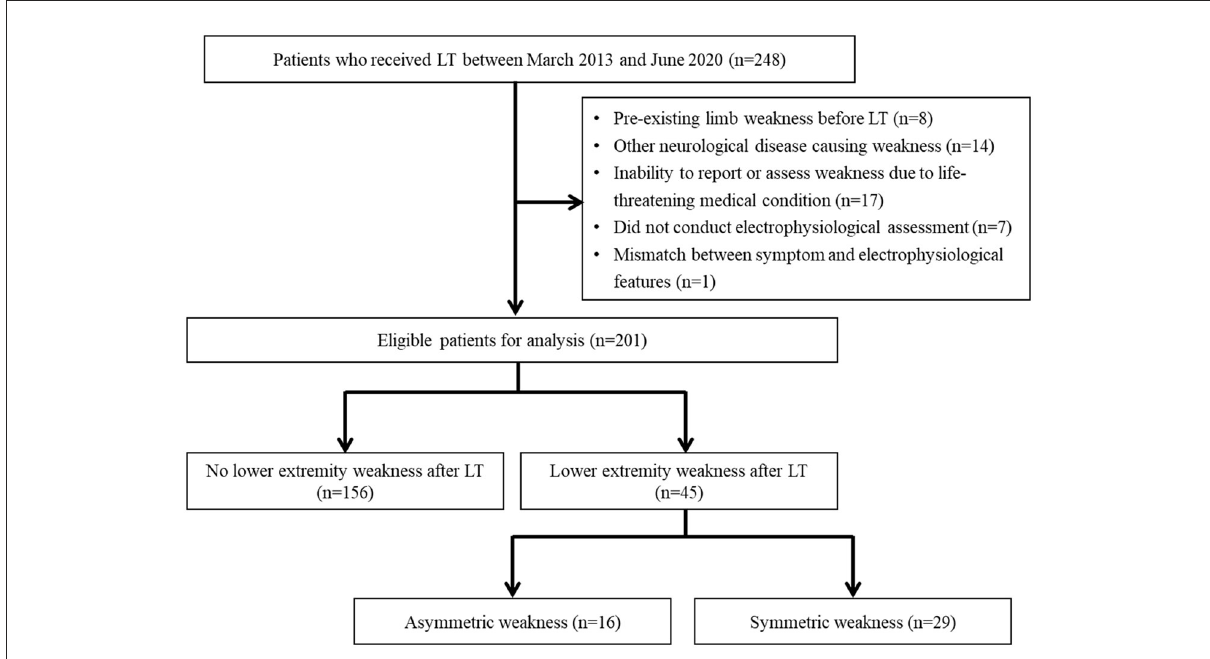
FIGURE1 The study design and flow diagram of the patient selection